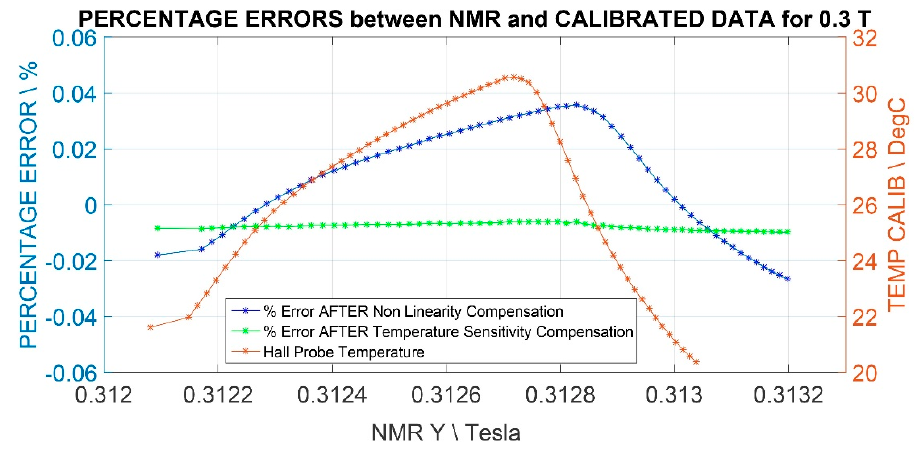
Figure 21. Graph showing the additional improvement obtained in the percentage error spread by application of “Temperature Sensitivity Compensation” after “Non-Linearity Compensation” is applied when the Hall probe temperature is thermally cycled from 21 ◦ C up to 31 ◦